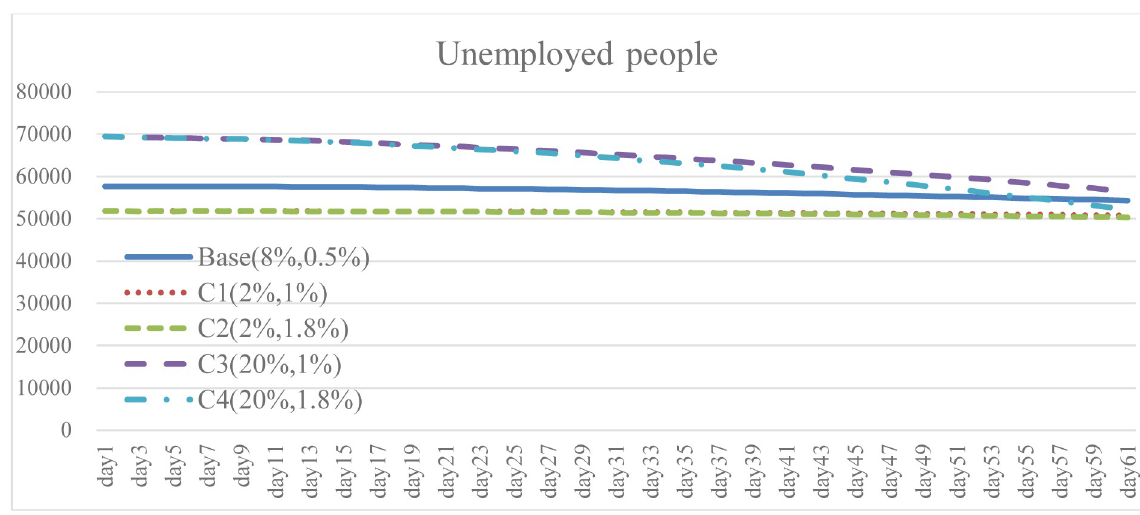
Fig 20. Unemployed people under different isolation percentage and vaccine supply.